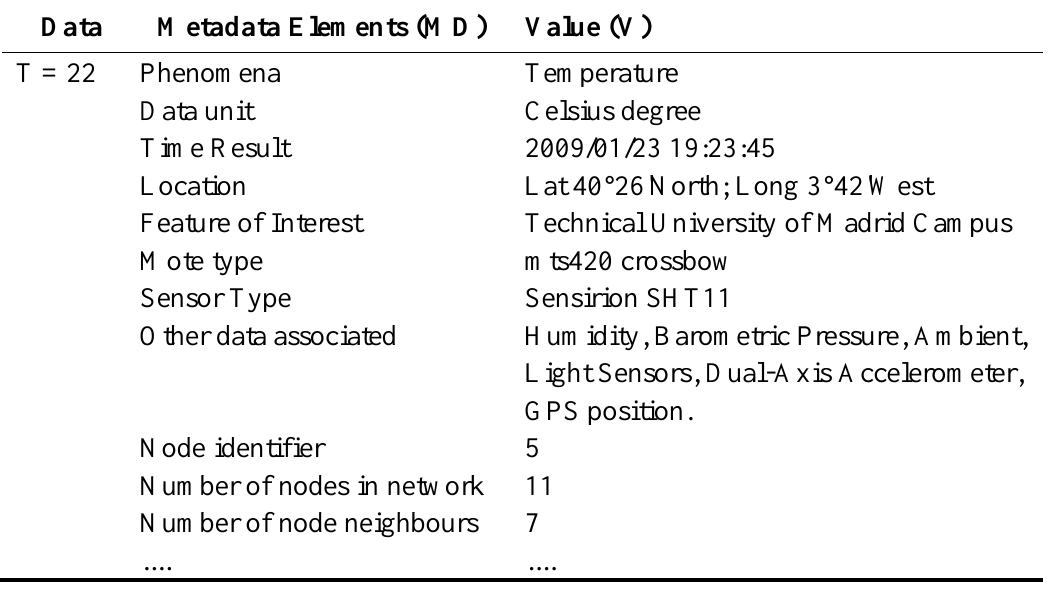
Table 1. Examples of WSN metadata elements for temperature